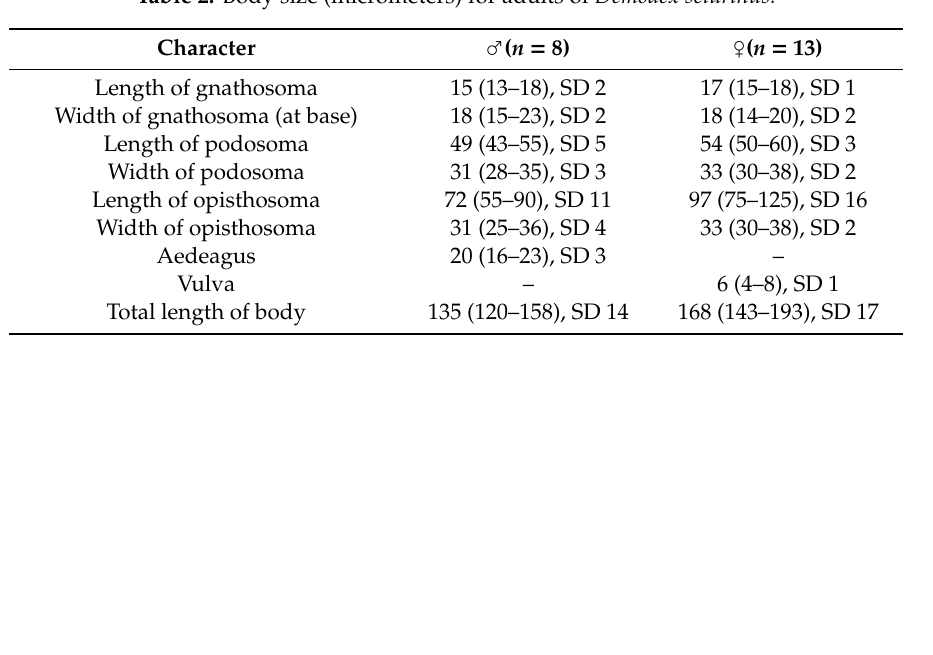
Table 2. Body size (micrometers) for adults of Demodex